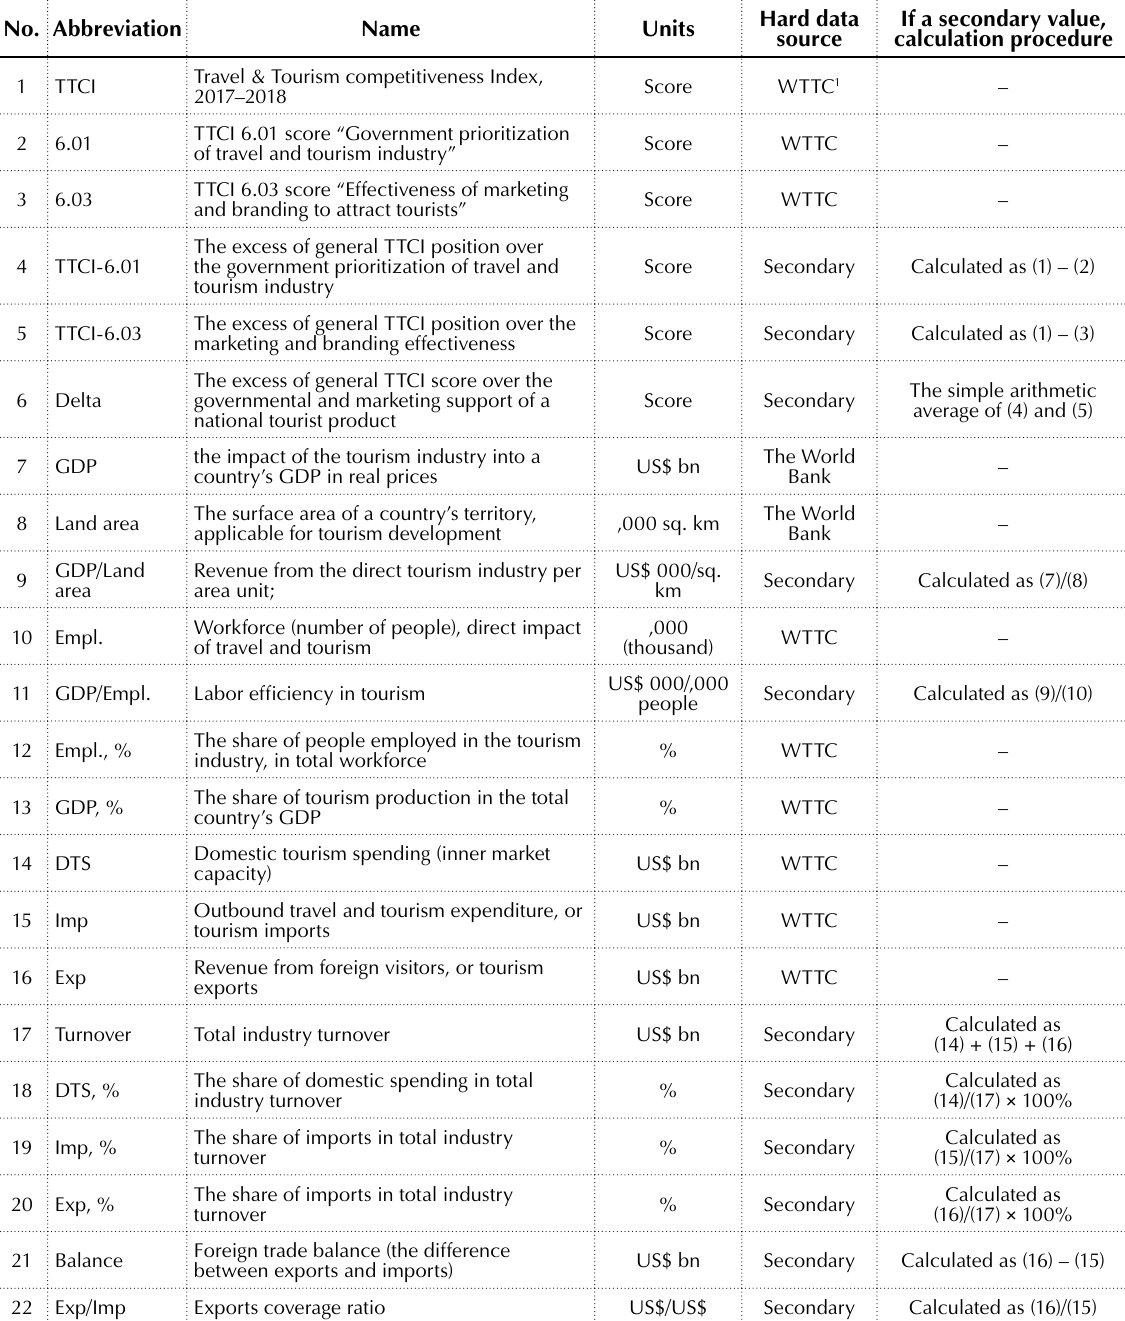
Table 1. Macroeconomic indicators of the national tourism industry (hard data) No.